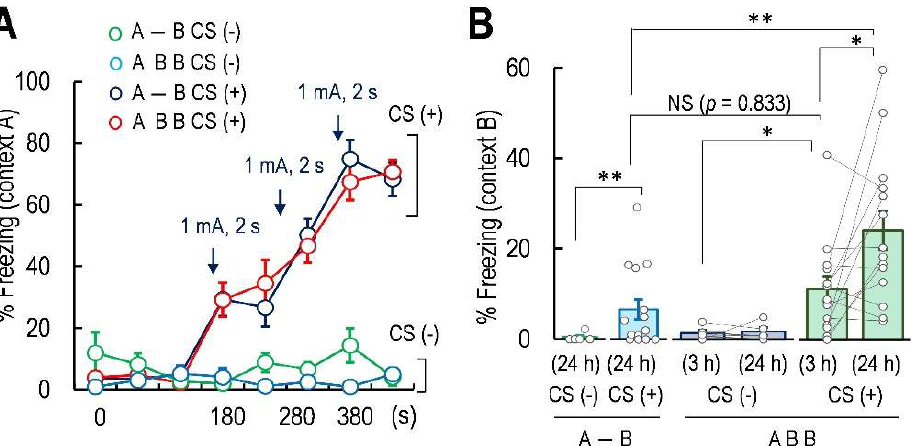
Figure 2. Freezing level in the contextual fear conditioning. ( A ) Percentage (%) of time spent in freezing during Context A, when the electric shocks (CS (+)) were delivered at 100 s after the mice were placed in the box. Arrows represent electric shock delivery at 180, 280, and 380 s after the mouse was put in the box. Freezing time was recorded every 1 min. ( B ) Bar graphs showing the percentage of freezing level in Box B 24 h in A-B CS ( − ) (n = 5), Box B at 3 and 24 h in ABB CS ( − ) (n = 5), Box B 24 h in A-B CS (+) (n = 15), and Box B 3 and 24 h in ABB CS (+) mice (n = 14). Data are represented by mean ± SEM. NS represents no significant difference. * p < 0.05; ** p < 0.01.